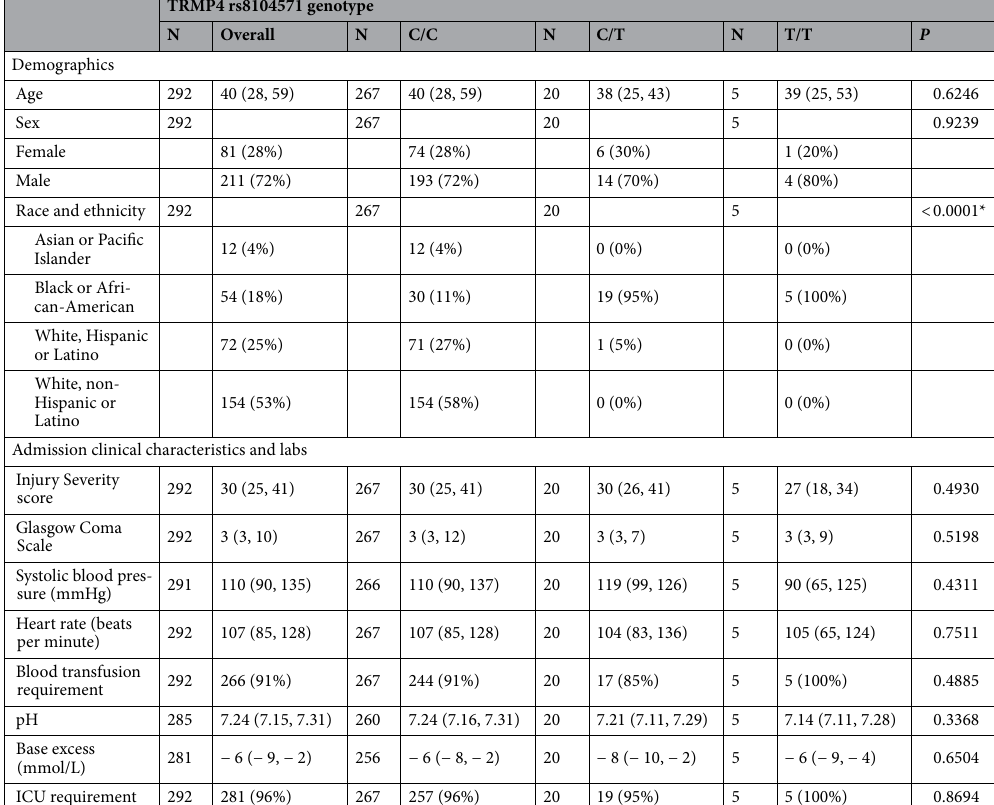
Table 2. Demographics, clinical characteristics, and TRMP4 rs8104571 genotype distribution for the overall study population denoted as median (IQR) or number of observations (%). C cytosine, T thymine, ICU intensive care unit, IQR interquartile range, *Significant P values <